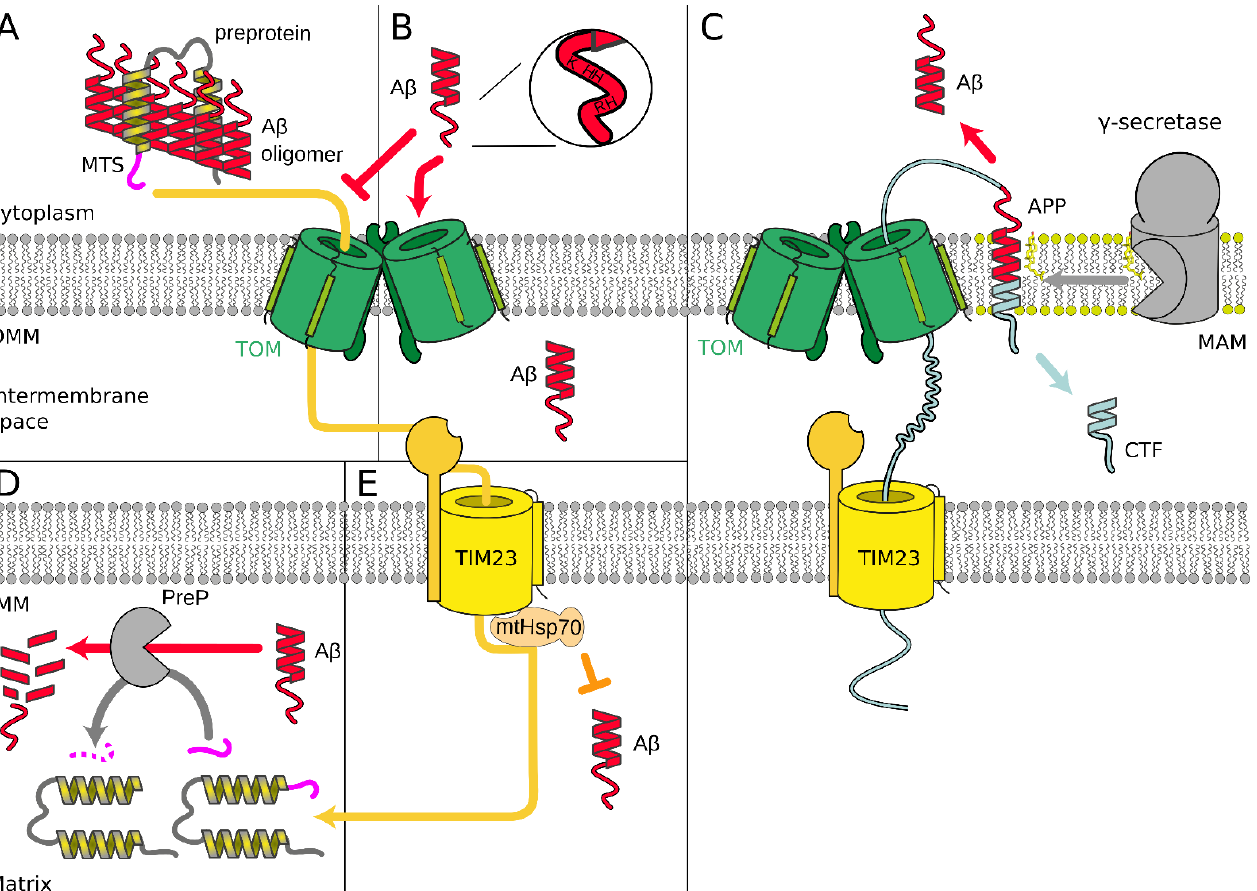
Figure 3. ( A ) Aβ peptides form cytosolic Aβ–preprotein coaggregates that inhibit the initial steps of the